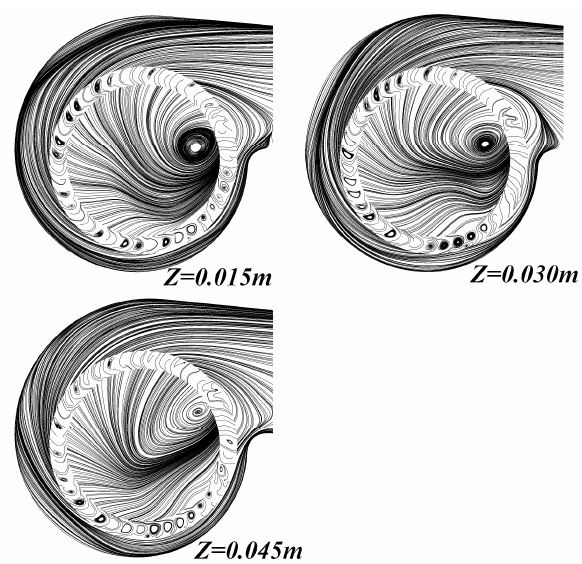
Figure 15. Streamline of cross-sections at different positions (Q/Qn = 1.758).